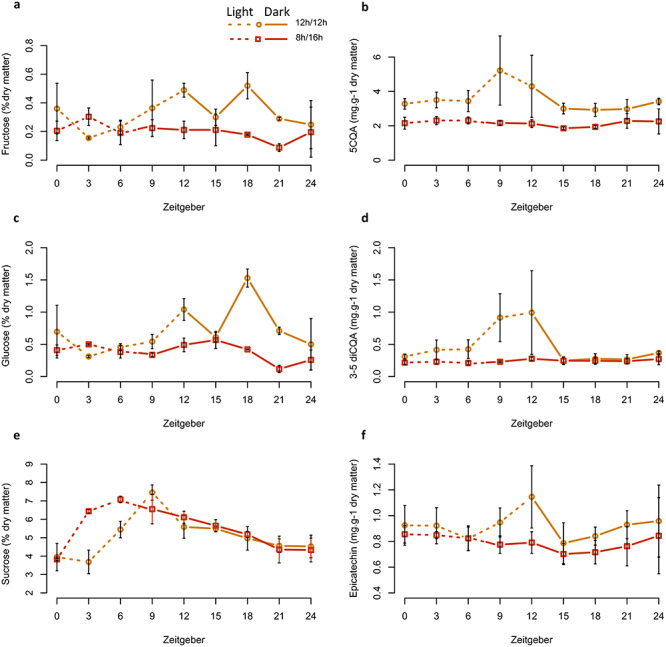
Influence of photoperiod on sugar (sucrose, glucose and fructose) and phenolic (5CQA and epicatechin) contents in leaves. Content in major soluble carbohydrates (a) fructose and phenolics, (b) 5CQA, (c) glucose, (d) 3-5 diCQA, (e) sucrose and (f) epicatechin in leaves submitted to photoperiod 12 h/12 h (orange line) and 8 h/16 h (red line). Dashed line represents a light period and the solid line represents the dark period. For all sugars and phenolics, values are expressed in mg 100 mg−1 dry matter, respectively. Error bars are means ± SEM of three experimental replicates.